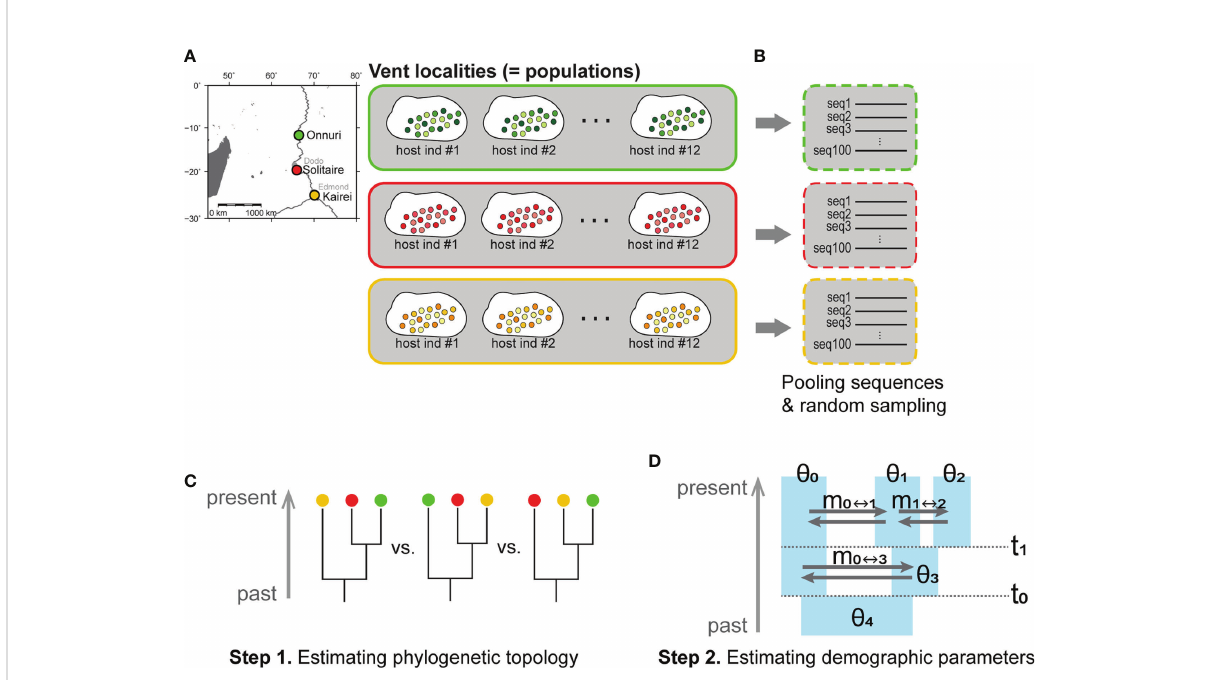
FIGURE 2 Hierarchical level of symbiont populations examined in this study and steps for IMa3 analyses. (A) De fi nition of a population in this study. The sequences from the same vent fi eld were regarded as a population regardless of individual hosts. (B – D) Inference about demographic history based on the isolation with migration (IM) model using the IMa3 software: (B) Preparation of an input fi le, (C) Step 1. Estimation of phylogenetic topology, (D) Step 2. Analysis of demographic parameters scaled by mutation rate ( q , population size; m, migration rate; t, splitting time) (Hey et al.,